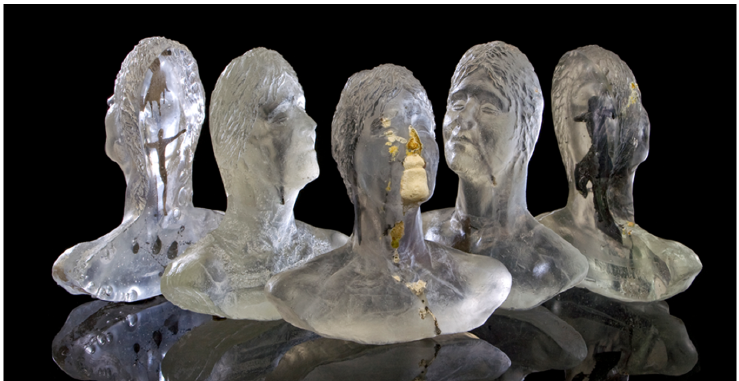
Figure 3. Goshka Bialek; self-psychoanalysis V; 2017; variety of inclusions in glass: using water jet cut nickel, tin and lead alloy sheets, gallium and silkscreen printings, cast hot glass into moulds; photographed by David Williams. Used with permission.